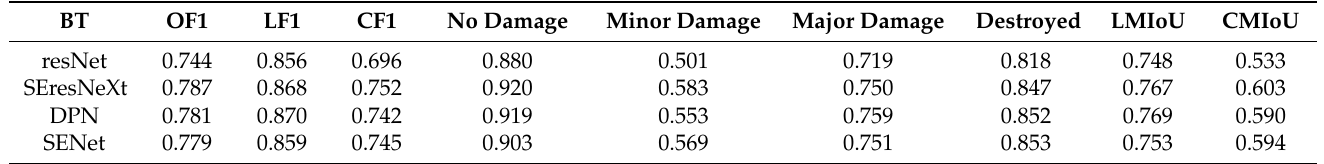
Table 5. Indicators of different models with the attention (w A) mechanism.